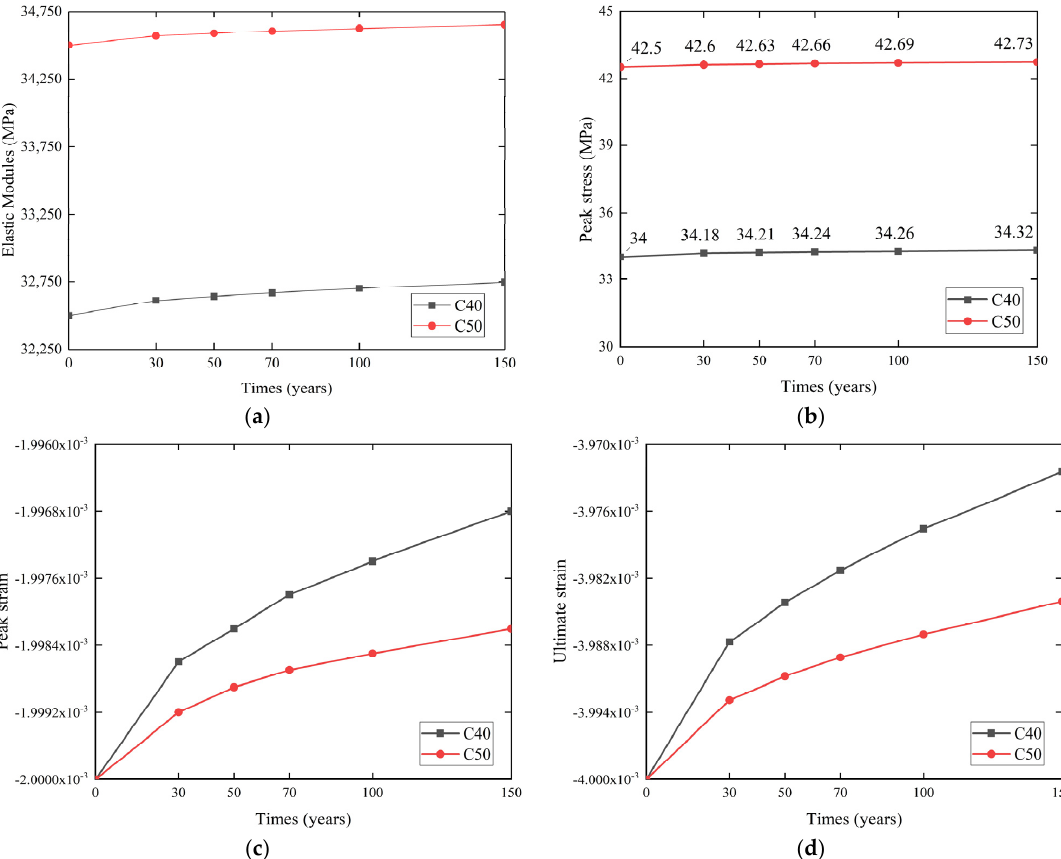
Figure 1. The mechanical parameters of concrete: ( a ) Elastic modulus; ( b ) Peak stress; ( c ) Peak strain; Figure 1 ( d ) Ultimate